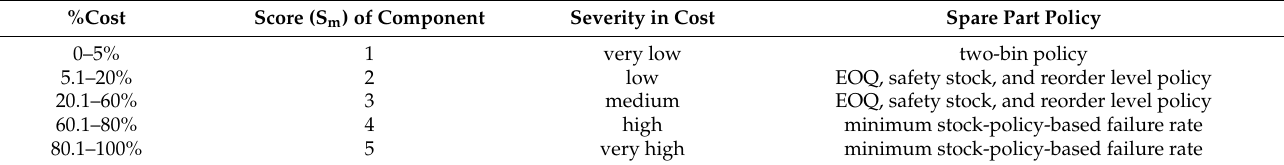
Table 6. Proposed spare part policy in an inventory management system for individual transmission components.